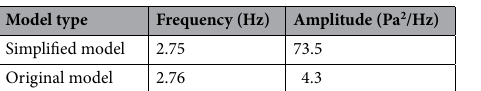
Table 1. The characteristic parameters of power spectral density